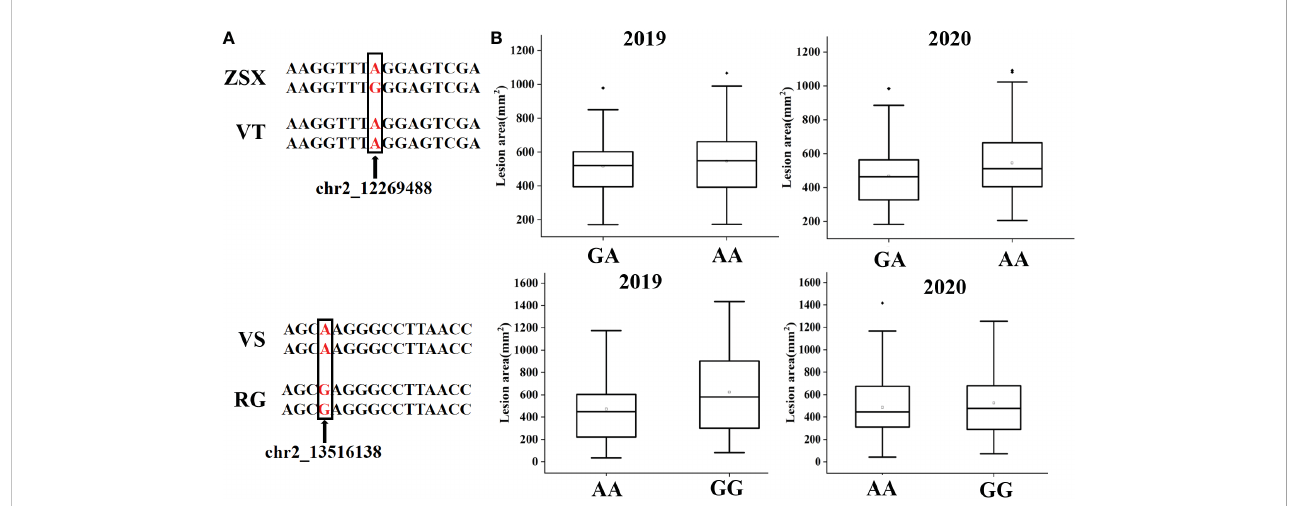
FIGURE 5 Distributions of grape hybrid gray mold lesion area according to the markers chr2_12269488 and chr2_13516138 in the population of ‘ ZSX ’ × ‘ VT ’ and ‘ RG ’ × ‘ VS. ’ (A) Base information of markers chr2_12269488 and chr2_13516138 in different cultivars and the fl anking sequence. (B) Gray mold lesion area distribution of F1 progeny from the population of ‘ ZSX ’ × ‘ VT ’ and ‘ RG ’ × ‘ VS ’ in different years.